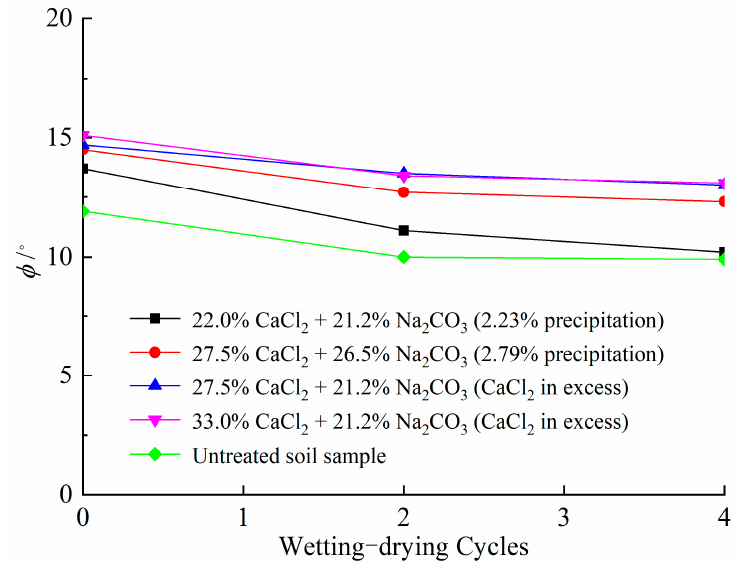
Figure 15. Variations in friction angle versus wetting–drying cycles.